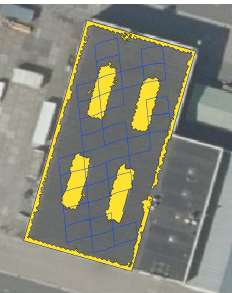
Figure 10. Example of a visualization obtained during the validation. Mapped ‘deviations’ are shown in yellow and can be overlaid with the (modified) pixels resulting from hyperspectral imagery pixels and contained in the building roofprint (geometry in blue). Settings used: distance threshold 20 cm and angular threshold 2 ◦ .